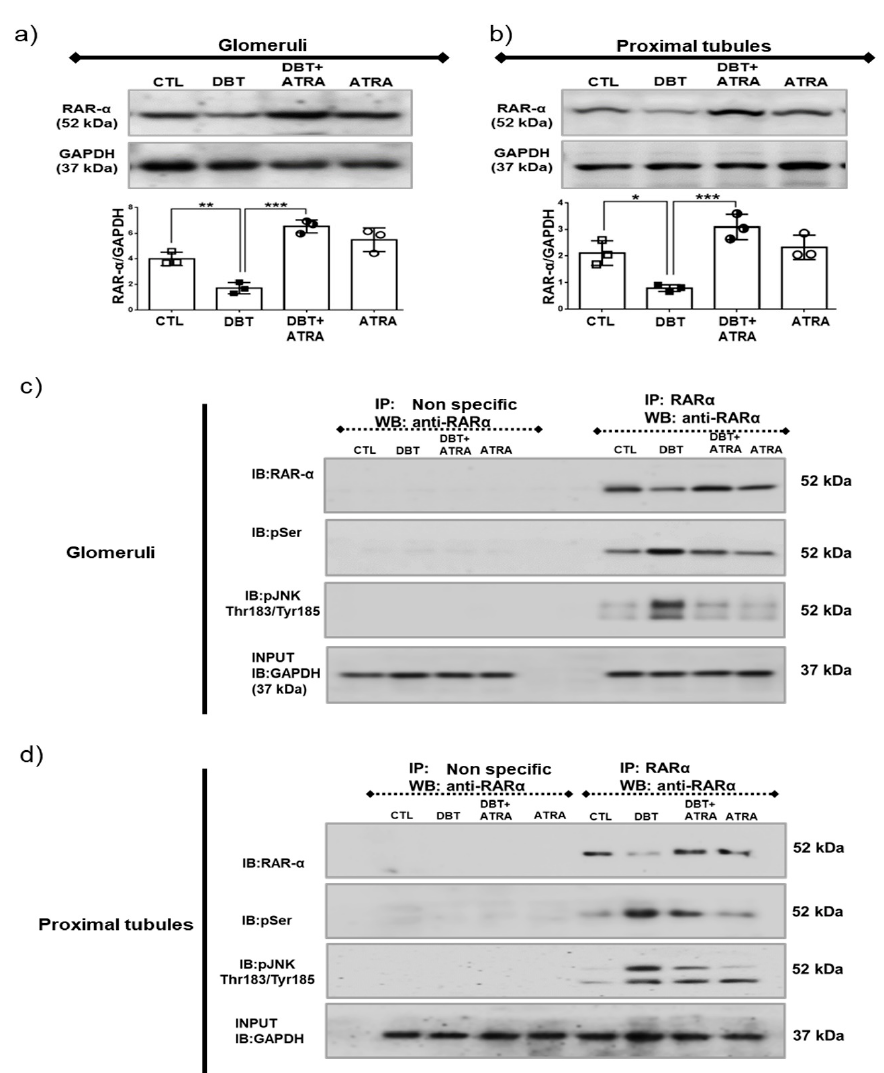
Figure 8. All-trans retinoic acid (ATRA) inhibited STZ-induced phosphorylation and loss of retinoic acid receptor alpha (RAR- α ) expression by c-Jun N-terminal kinase (JNK). Western blot analysis of RAR- α in ( a ) in isolated glomeruli and ( b ) proximal tubules. To evaluate whether hyperglycemia-induced degradation of RAR- α is regulated by its phosphorylation, cell lysates of ( c ) isolated glomeruli and ( d ) isolated tubules were studied by immunoprecipitation (IP) with antibody to RAR- α , followed by immunoblot (IB) analysis with anti RAR- α and anti-phosphoserine antibody. To evaluate that JNK promotes phosphorylation of RAR- α IP analyzes were performed. Diabetes downregulates the expression of RAR- α by its phosphorylation in serine residues mediated activation of JNK. ATRA treatment decreased these changes. As shown in panels ( c ) and ( d ), no signal was found under nonspecific conditions of IP performed with an unrelated antibody. GAPDH was evaluated in input extracts as loading control. Data are representative of three independent experiments, and values are expressed in mean ± SD. * p < 0.05, ** p < 0.01, *** p < 0.001.